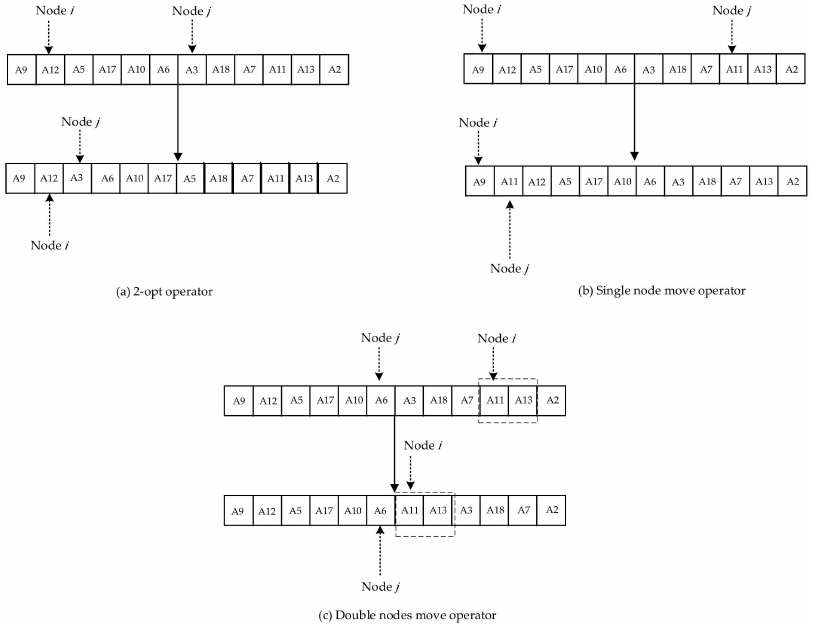
Figure 5. Examples of variable neighborhood